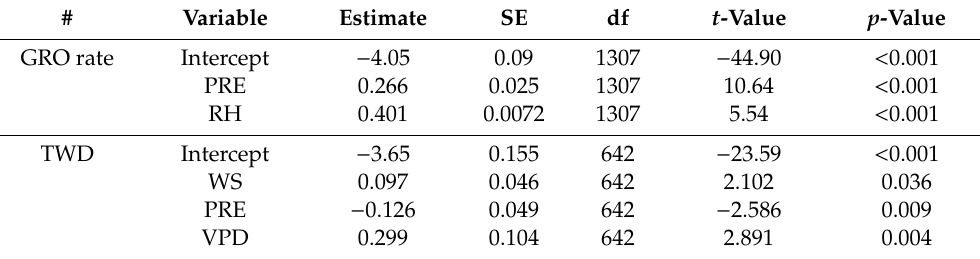
Figure 6. Correlation coe ffi cients between monthly stem growth rate (GRO rate, a ) and tree water deficit (TWD, b ) and climatic variables from March to October for the years 2012–2015 and 2017. T mean : mean air temperature; PRE: precipitation; RH: relative humidity; PAR: photosynthetic active radiation. N ranges from 289 to 358, and all correlations with a coe ffi cient above 0.18 are significant at the p < 0.01 level. Table 1. Parameter estimates for the selected linear mixed-e ff ects models fitted to explain the variations of daily sums of growth-induced irreversible stem expansion (GRO rate) and daily minimum tree water deficit (TWD). Mixed-e ff ects models were performed separately for GRO rate and TWD, with climate variables as fixed factors and individual trees nested in years and a first-order auto-correlation structure as random factor. PRE: precipitation; RH: relative humidity; WS: wind speed; vapor pressure deficit (VPD); SE: standard error; df: degrees of